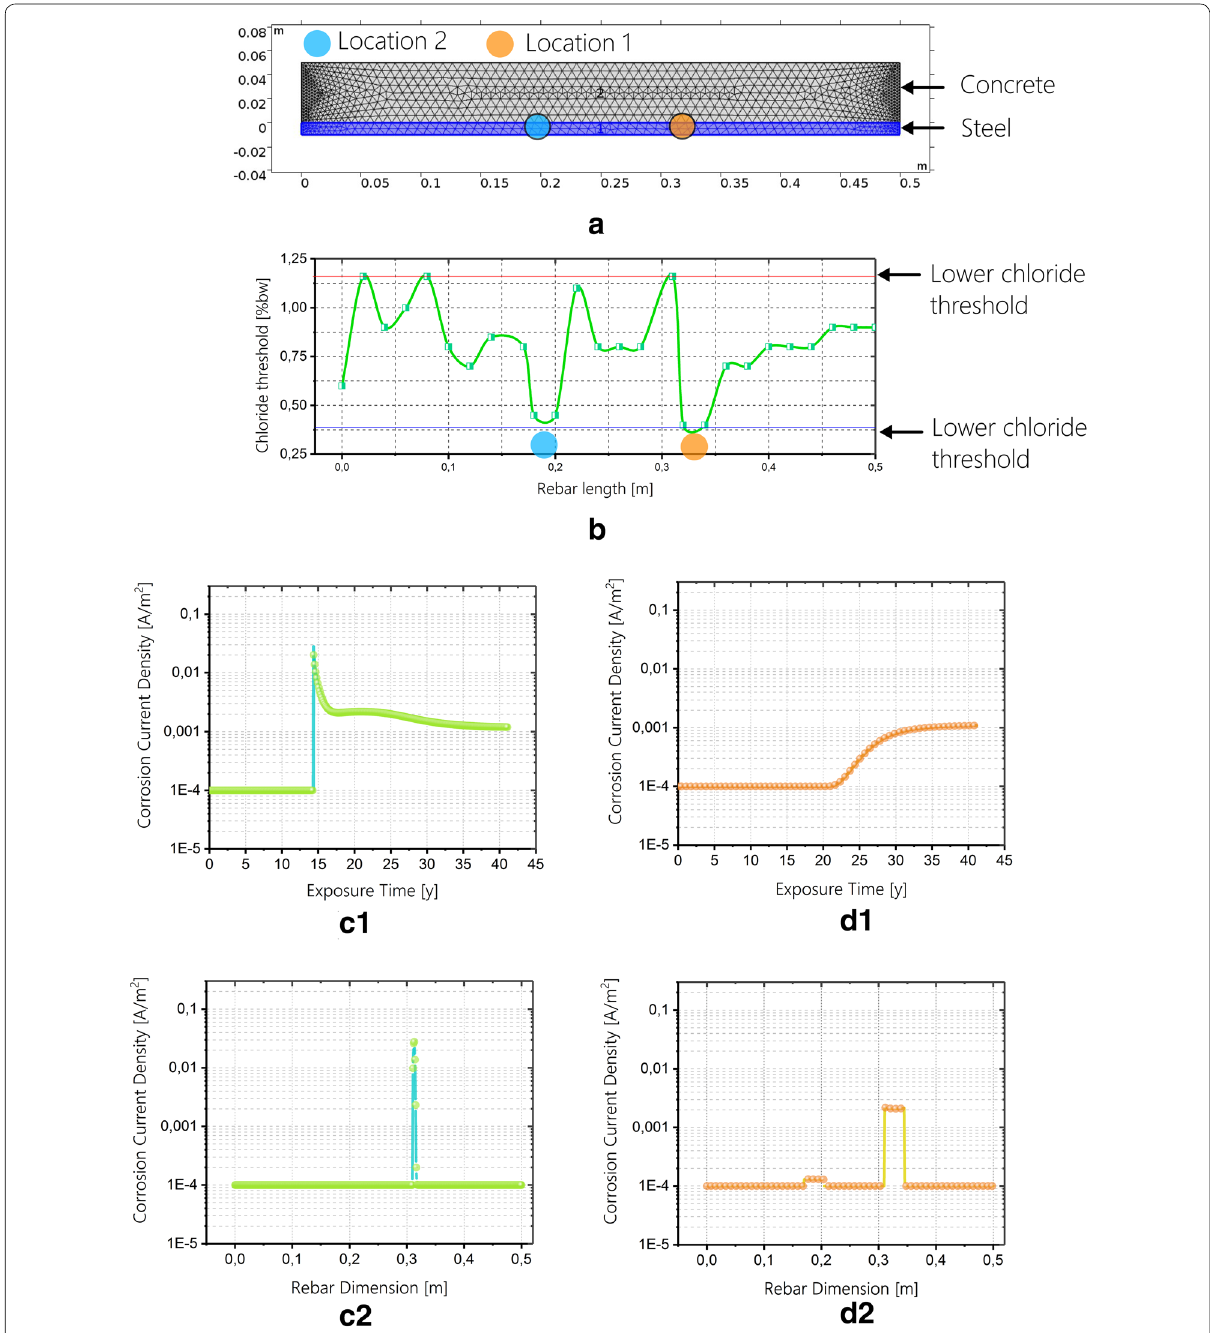
Fig. 6 a 2D numerical model with triangular elements. Current evolutions are monitored at locations 1 and 2. b Random varying chloride threshold applied at rebar surface. Alonso et al. (2000) with 0.39 < Cl th < 1.16 (free Cl − as %binder weight). c1 Evolution of current density at location 1 with time. c2 Current density at location 1 on the onset of depassivation. d1 Time evolution of current density at location 2. d2 Corrosion current density at location 2 on the onset of depassivation at location